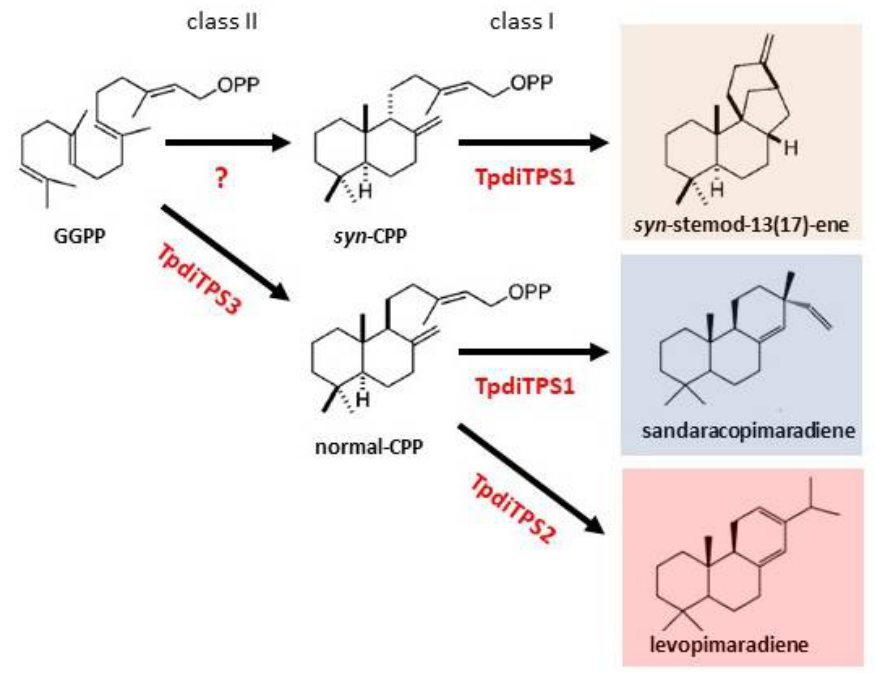
Figure 9. Model of the monofunctional diterpene biosynthesis pathway potentially active during heartwood formation in WRC trees based on the results in this study. The question mark indicates that an unidentified syn -CDP synthase may also be active to provide an alternative substrate for TpdiTPS1. The peptide sequences of TpdiTPS1 and 2 lacked an intact N-terminal DXDD motif but contained the C-terminal DDXXD motif required for the rearrangement of CDP to diterpene hydrocarbons, typical of class I diterpene synthases [38,64]. In agreement with their motif profile, both TpdiTPS1 and 2 produced diterpenes when co-expressed with proteins providing CDP. TpdiTPS1 accepted normal and syn -CDP as a substrate, but not ent -CDP. TpdiTPS1 produced sandaracopimaradiene in the presence of normal-CDP and syn -stemod-13(17)-ene in the presence of syn -CDP. The use of syn -CDP suggests that a syn -CDP synthase may be expressed during WRC heartwood